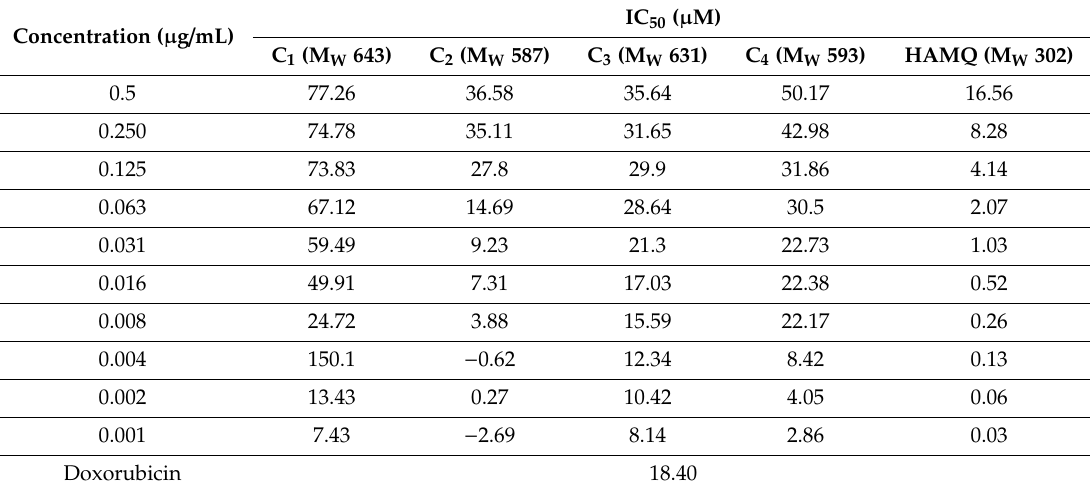
Table 2. Concentrations of the complexes used in SRB assay with the values converted to µ M. M W , molecular